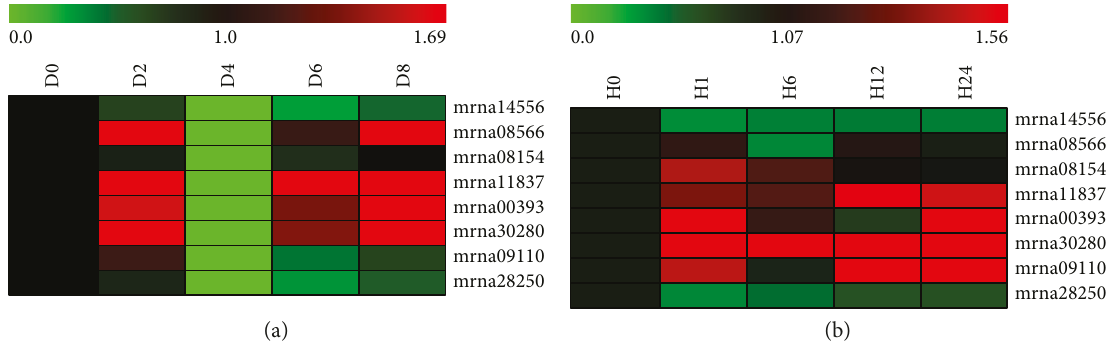
Figure 6: Heatmap of clade A FvbZIP genes expressed under drought (a) and heat (b) treatments. This heatmap was generated based on the RT-PCR data (normalized) using the MeV software. Green indicates low expression, black indicates intermediate expression, and red indicates high